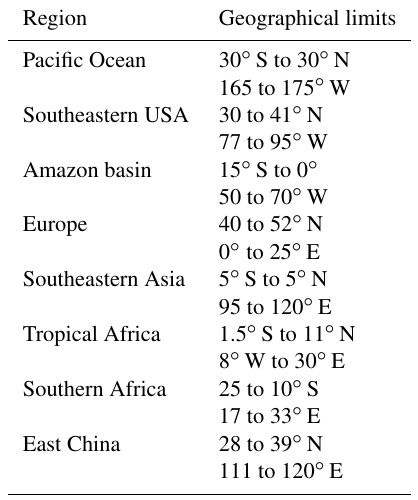
Table 3. Geographical limits of the regions depicted in Fig. 6. Region